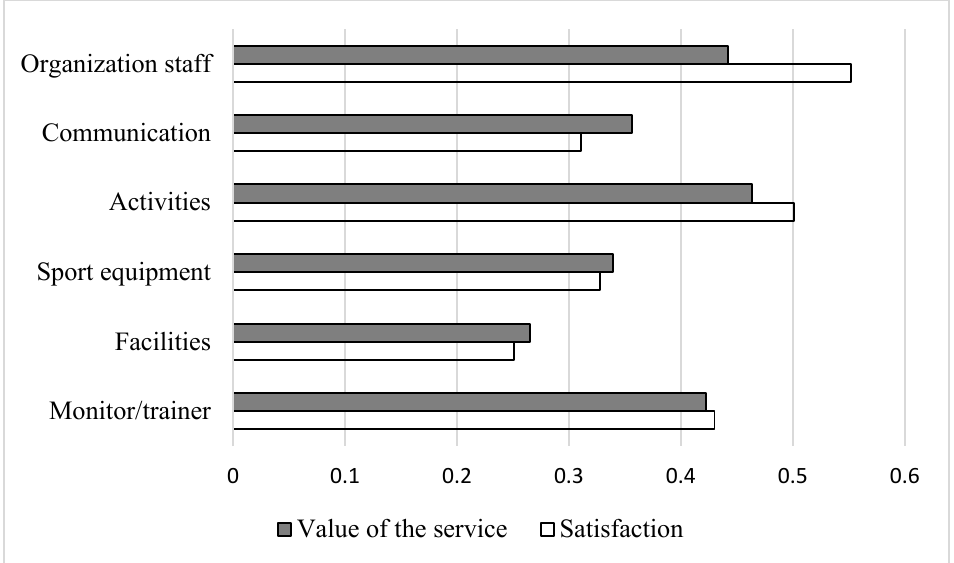
Figure 1. Bivariate correlations (Spearman) between the sub-factors of perceived quality and overall service value and satisfaction.